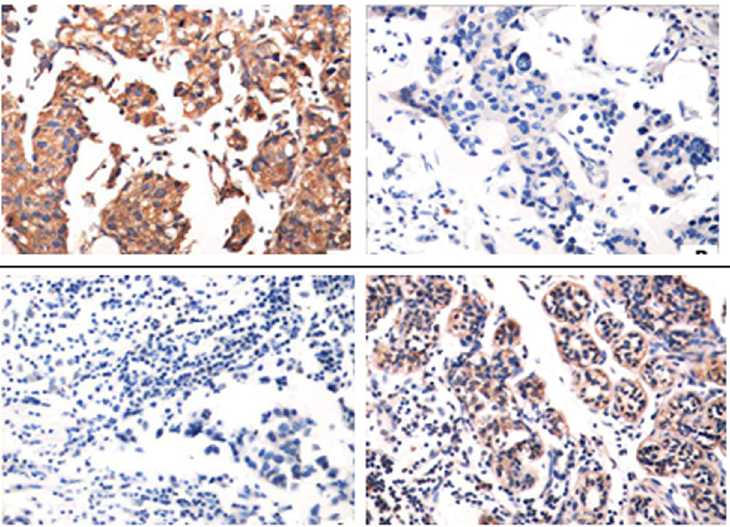
Fig 1. Detection of iNOS protein levels in TNBC tissues by immunohistochemistry. Top panel: demonstration of iNOS levels in patient ’ s tumor changing from positive to negative after treatment in IDC. Bottom panel: demonstration of iNOS levels in patient ’ s tumor changing from negative to positive after treatment in ILC.